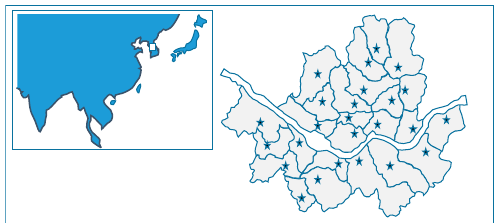
Figure 1. Air pollution monitoring stations in Seoul, Korea.